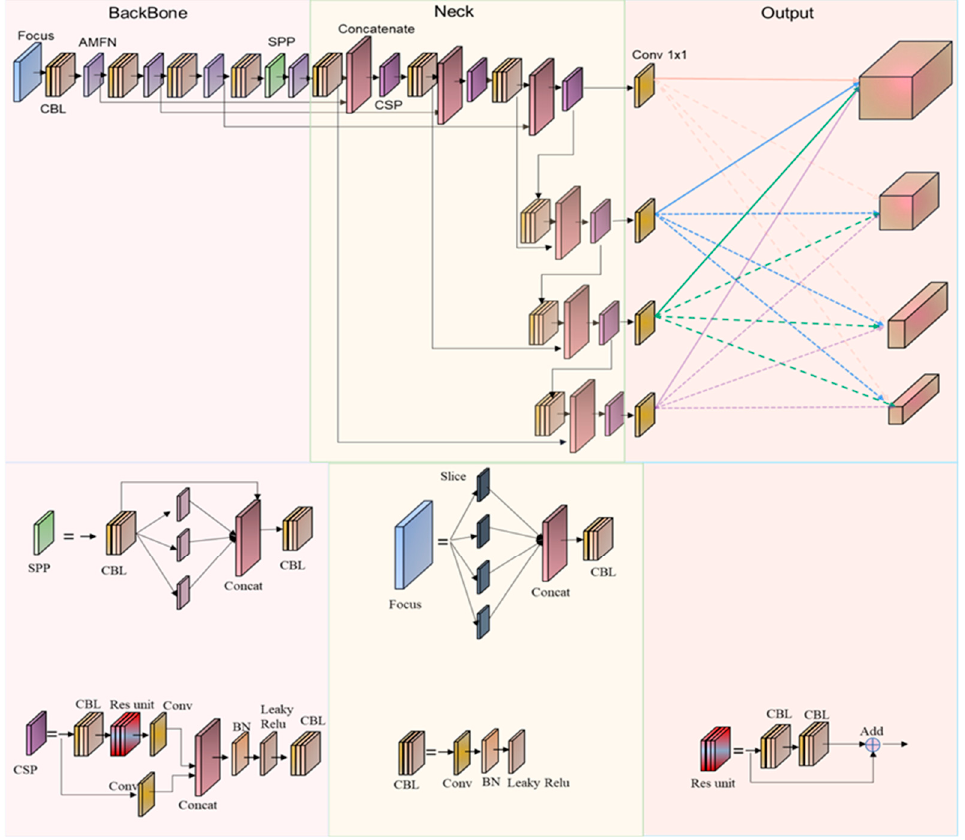
Figure 1. The architecture of AMFN-YOLOv5 (among them, the parts we optimized are the design of the new backbone network part AMFN and the adaptive pyramid fusion strategy in the output. AMFN is in Section 3.2.1, and the adaptive pyramid fusion strategy is in Section 3.2.2. SPP is spatial pyramid pooling, CSP is used for feature extraction, CBL is a component module of resnet, and Focus is an image slice operation).